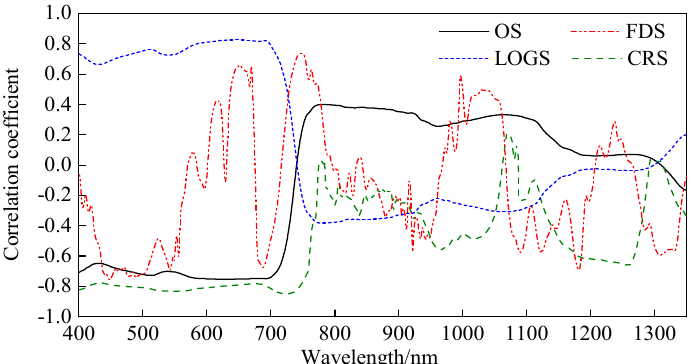
Figure 2. Correlation coefficients between leaf nitrogen concentration and transformed canopy spectra, including original spectrum (OS), first derivative spectrum (FDS), log-transformed spectrum (LOGS) and continuum removal spectrum (CRS).